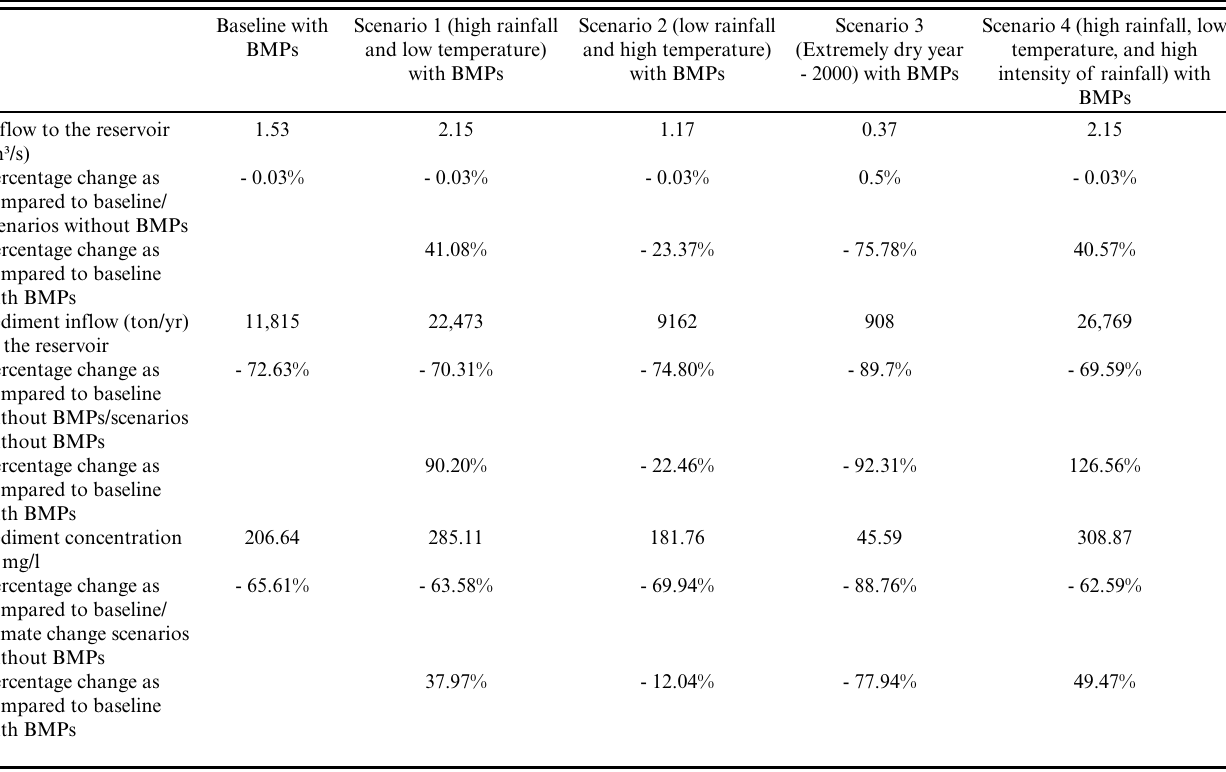
Table 7 . Water and sediment yield into Sasumua reservoir under baseline and different climate change scenarios after implementing best management practices